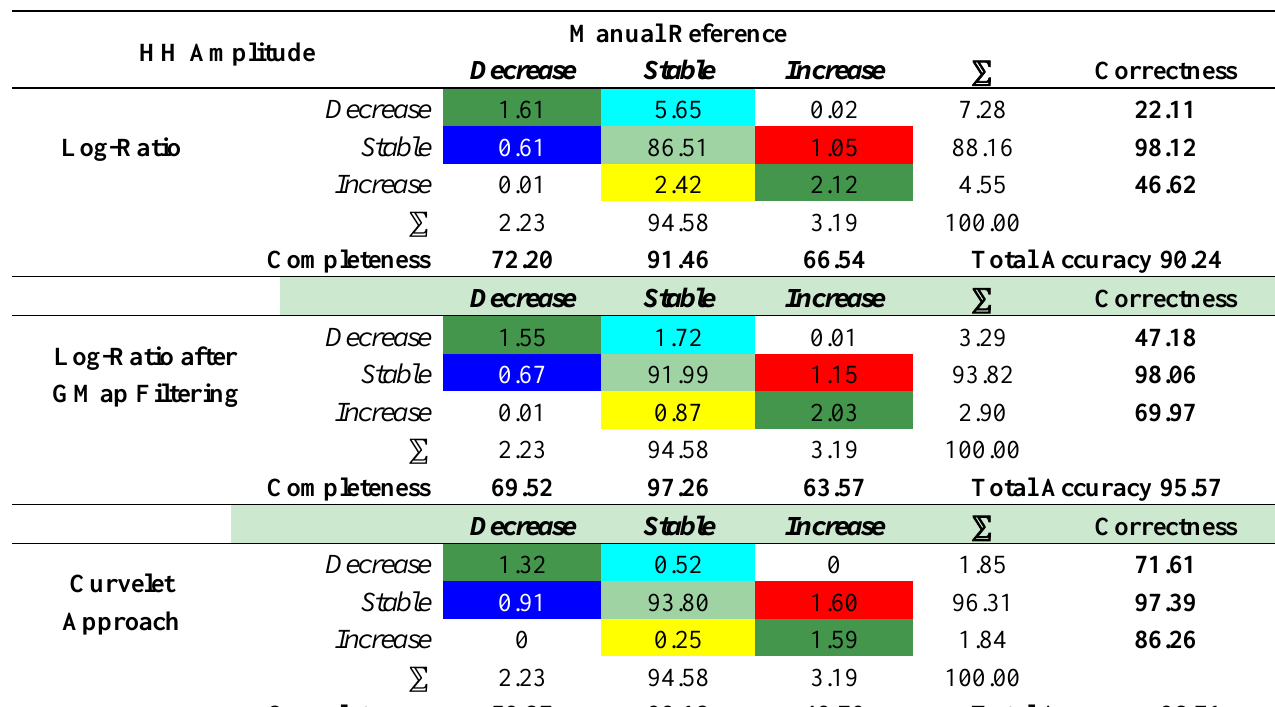
Table 2. Confusion matrix for all three automated methods in comparison to the manual